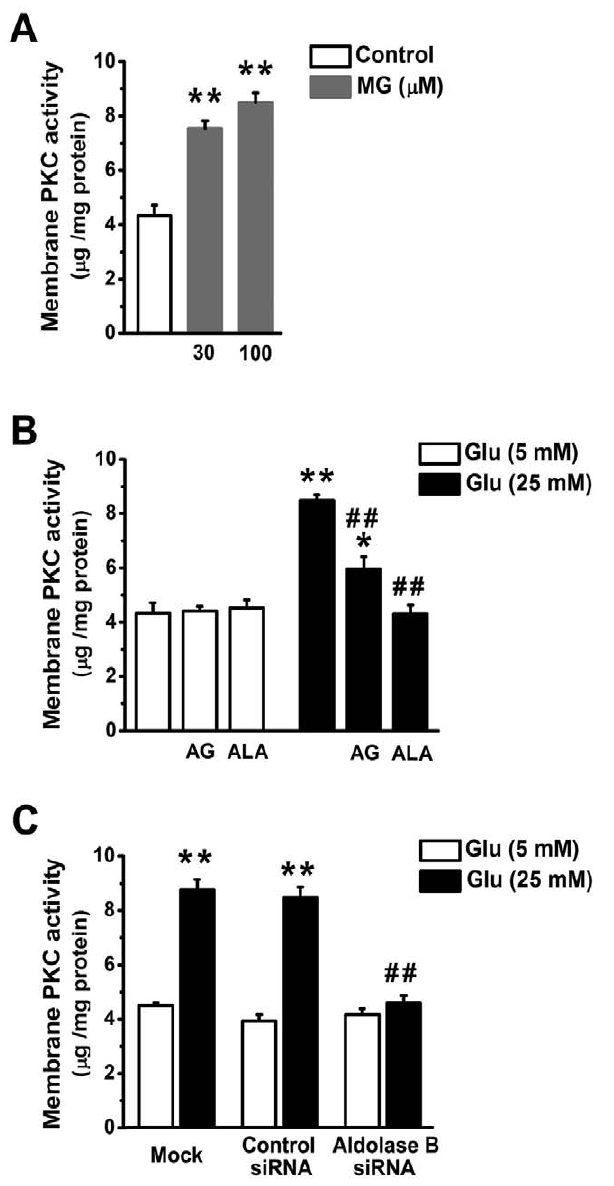
Figure 6. Knockdown of aldolase B prevented high glucose- increased membrane protein kinase C (PKC) activities in EA. hy926 cells. (A) Membrane PKC activities in cells treated with exogenous MG for 3 days. ** P , 0.01 vs . control (5 mM glucose). (B) Membrane PKC activities in cells treated with glucose (Glu) in the presence or absence of aminoguanidine (AG, 1 mM) and alagebrium (ALA, 100 m M). * P , 0.05, ** P , 0.01 vs . 5 mM glucose; ## P , 0.01 vs . 25 mM glucose. (C) Membrane PKC activities in cells transfected with control or aldolase B siRNA, or only transfection agent (mock). ** P , 0.01 vs . 5 mM glucose; ## P , 0.01 vs . control siRNA. doi:10.1371/journal.pone.0041495.g006 and differentiation [34]. MG (30 or 100 m M) increased nuclear p65 subunit of NF- k B in EA. hy926 cells ( P , 0.01) (Fig. 7A). High glucose-elevated nuclear amount of NF- k B p65 was similar with that induced by 100 m M MG ( P = 0.82), and prevented by alagebrium ( P , 0.01), aminoguanidine ( P , 0.01), and aldolase B knockdown ( P , 0.01) (Figs. 7A, 7B, 7C).